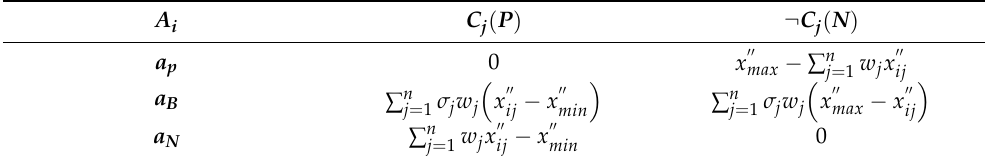
Table 4. Comprehensive relative loss function of